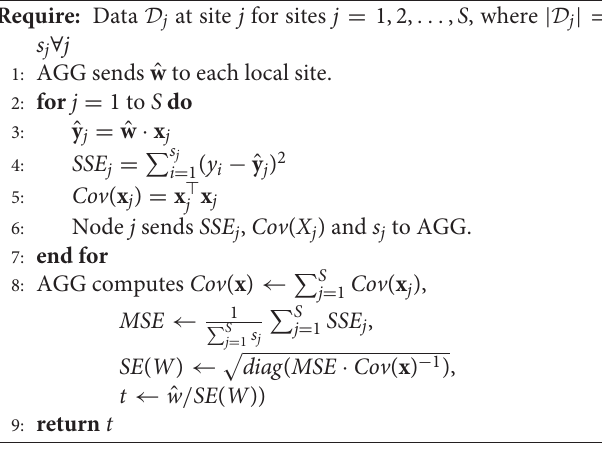
Algorithm 5 Decentralized t -value calculation